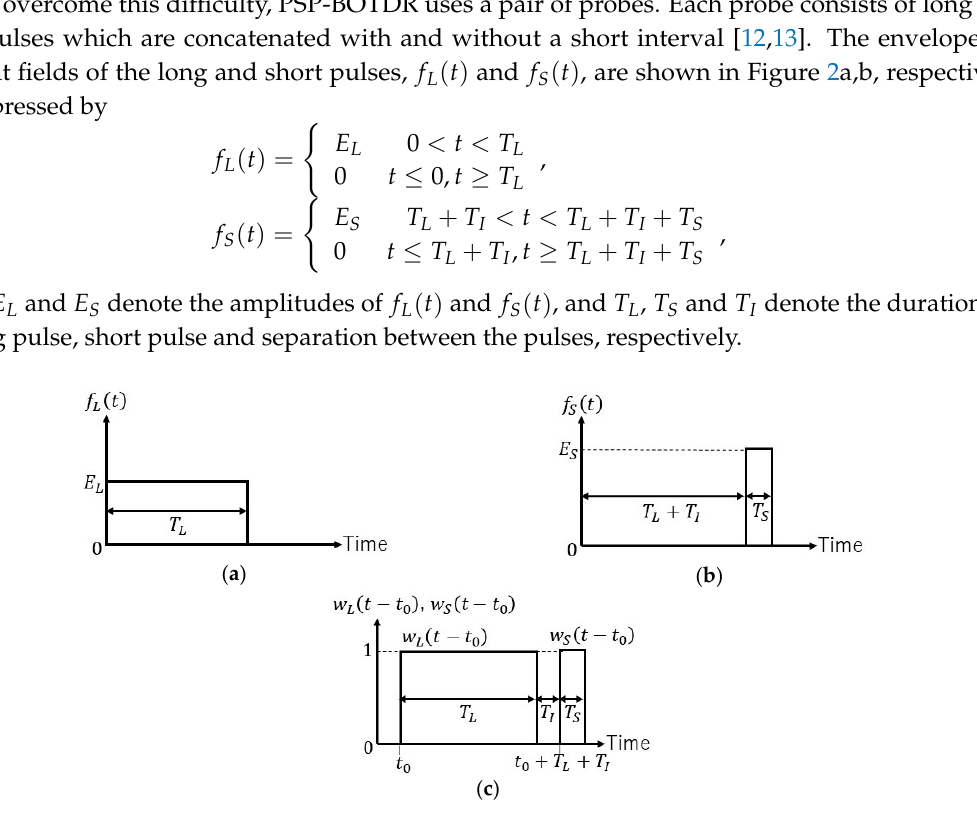
Figure 2. Electric field envelopes and window functions: ( a ) electric field envelope, f L ( t ) , of a long pulse; ( b ) electric field envelope, f S ( t ) , of a short pulse; ( c ) a pair of window functions related to long probe pulse and short probe